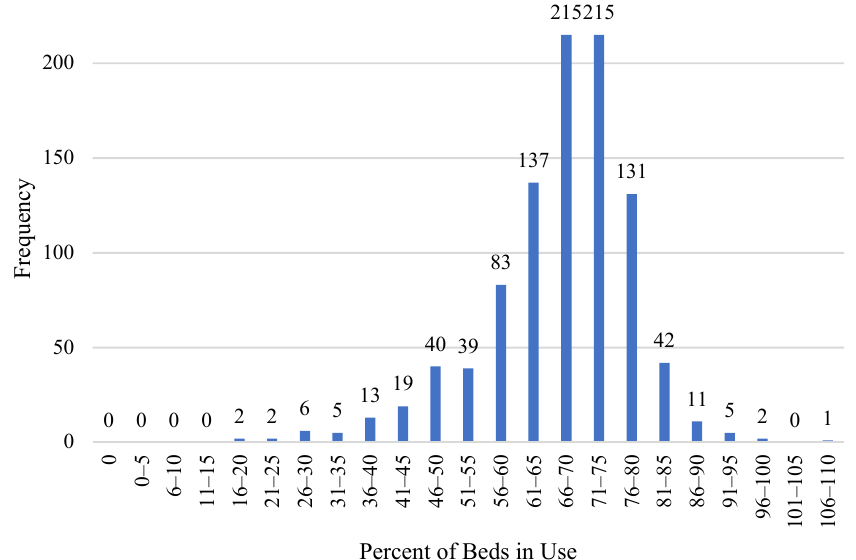
Figure 4. Frequency of Hospital Bed Usage Rates. Source: (COVID-19 Reported Patient Impact and Hospital Capacity by State Timeseries 2021).